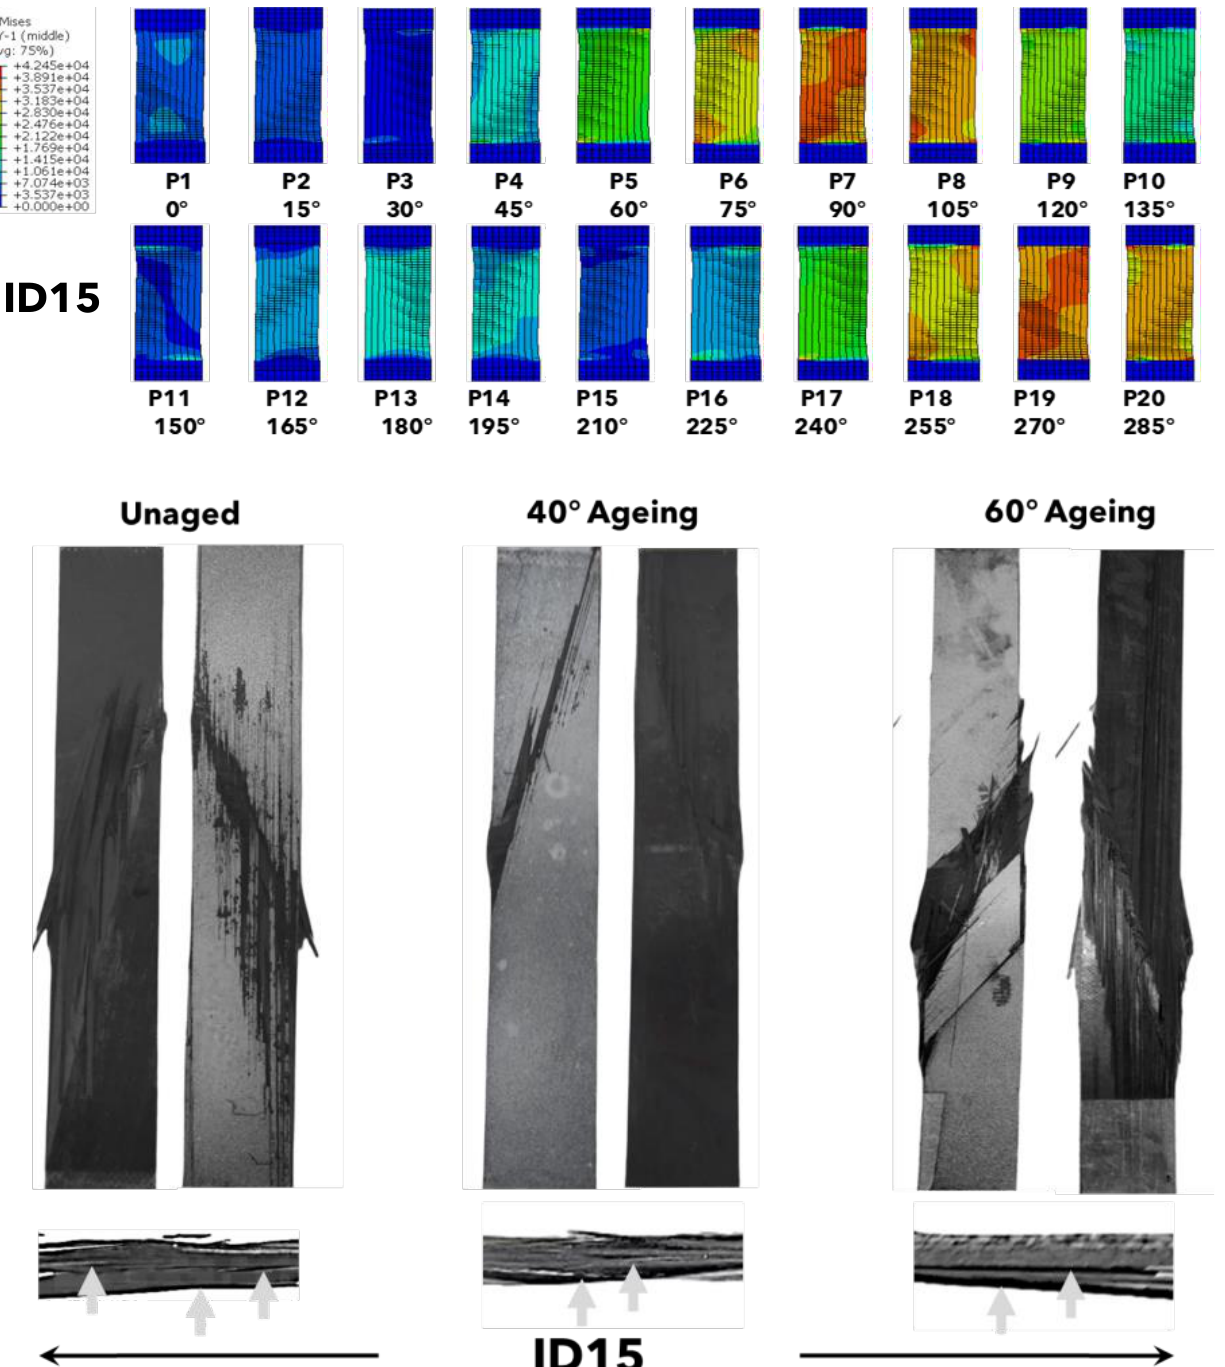
Figure 8. Stress (von Mises) distributions in individual dry plies predicted using the Hashin failure model, for ID15 composites ( top ), front and back face fractures from representative dry, 40 ◦ C, and 60 ◦ C aged samples ( middle ), and side view fractures from representative dry, 40 ◦ C, and 60 ◦ C aged samples ( bottom ), with arrows indicating the primary areas of fracture